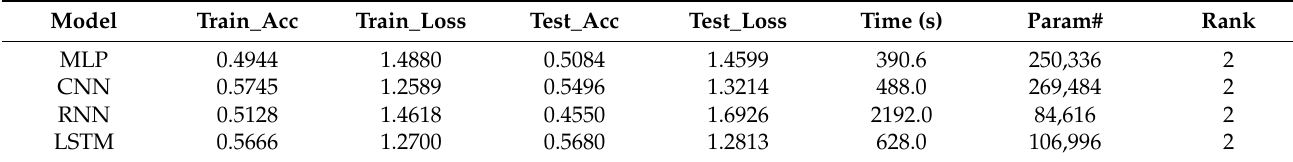
Table 3. Specific parameters and experimental results of each